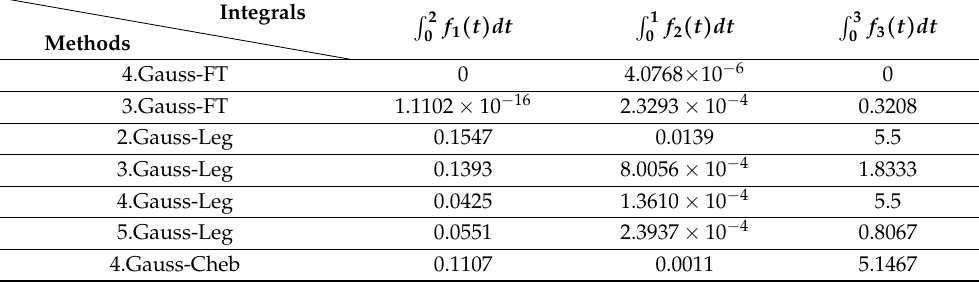
Table 1. The error estimates for various quadrature rules used in Example